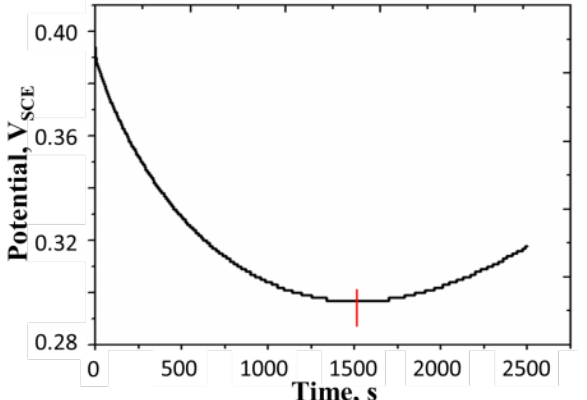
Figure 6. Linear current sweep chronopotentiogram performed on a polyaniline film. Concentration of H 2 SO 4 = 0.5 M, surface mass density of the film = 16.41 g m −2 , temperature = 25 °C; initial current= − 0.25 mA, current scan rate: 10 − 4 mA s − 1 , turning time = 1521 s. All potentials are reported with respect to SCE.